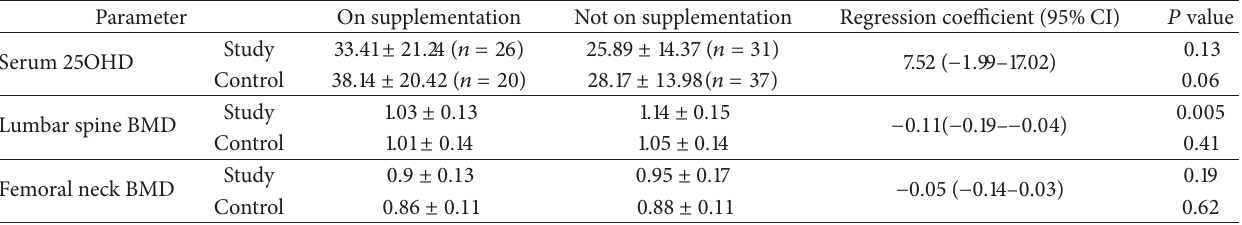
Table 4: Results of serum 25-hydroxyvitamin D, lumbar spine BMD, and femoral neck BMD in the study and control groups with regard to supplementation. CI: co nfidence interval; 25OHD: 25-hydroxyvitamin D; BMD: bone mineral density. Supplementation is in the form of calcium and vitamin